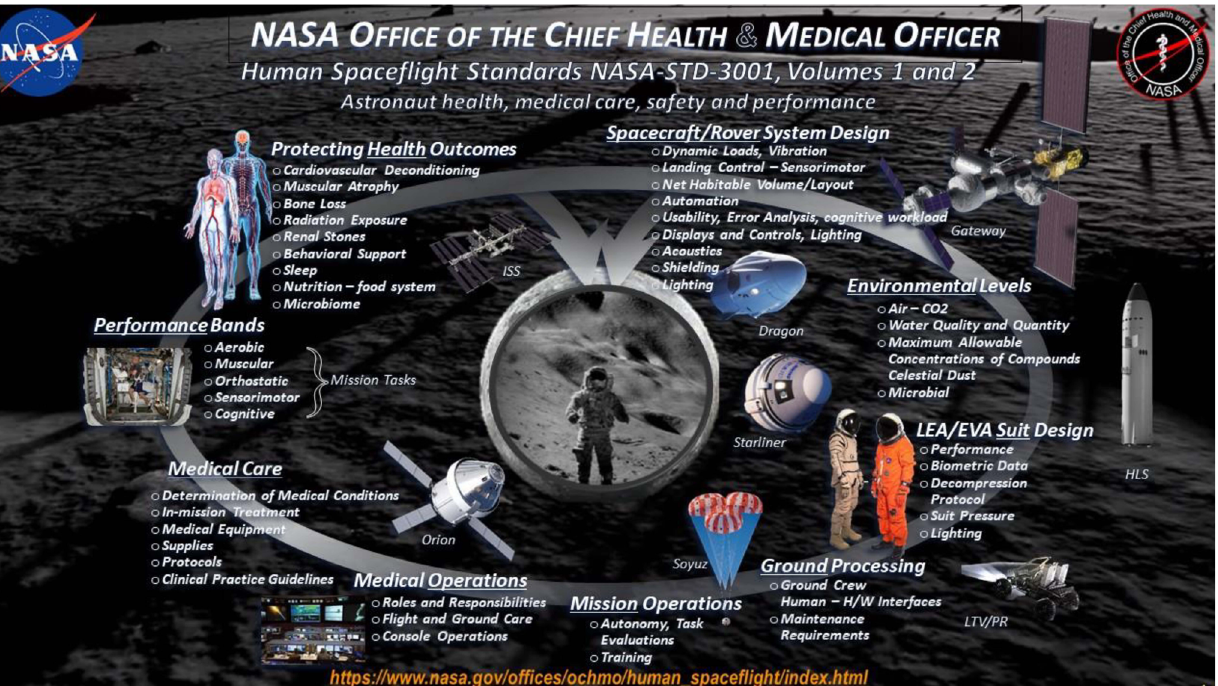
Fig. 1 Overview of NASA-STD-3001. An overview of the considerations for astronaut health and performance, and topics addressed in NASA- STD-3001 to guide designs to protect the